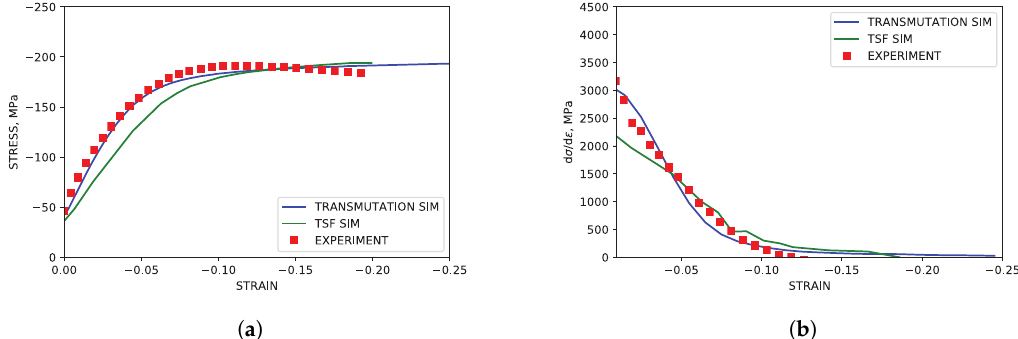
Figure 3. Simulated and experimental mechanical response under TTC compression. ( a ) Stress-strain. ( b ) Hardening rate vs. strain.